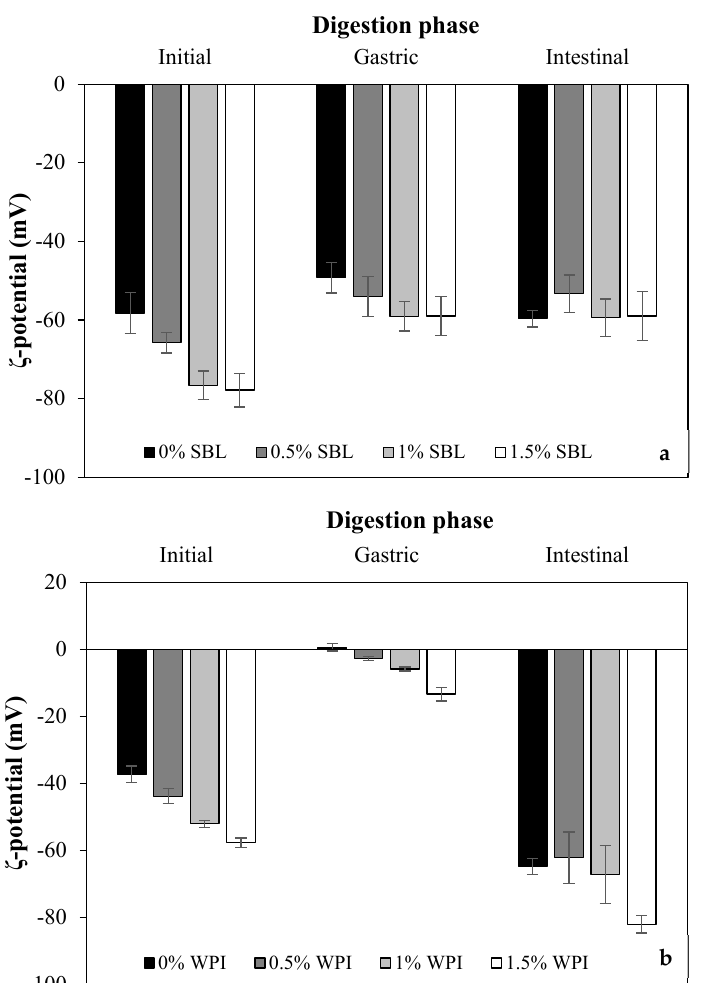
Figure 5. ζ -potential of curcumin-loaded nanoemulsions stabilized with ( a ) soybean lecithin (SBL) or ( b ) whey protein isolate (WPI) and different sodium alginate concentrations (0, 0.5, 1 and 1.5%) at different phases of in vitro digestion.